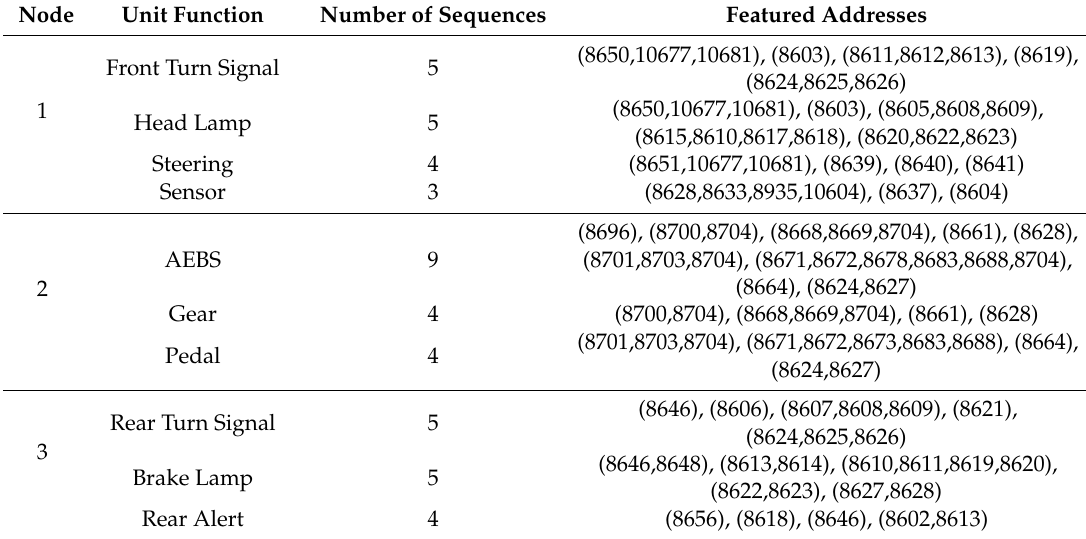
Table 2. List of memory-updated patterns of the system under test